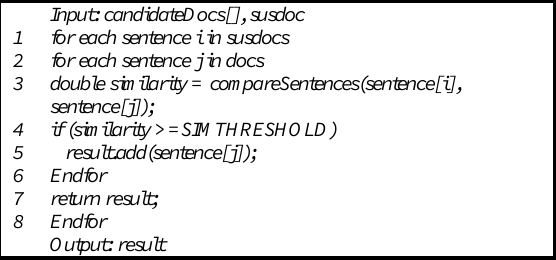
Figure 6. Pseudo-code for measuring similarity of